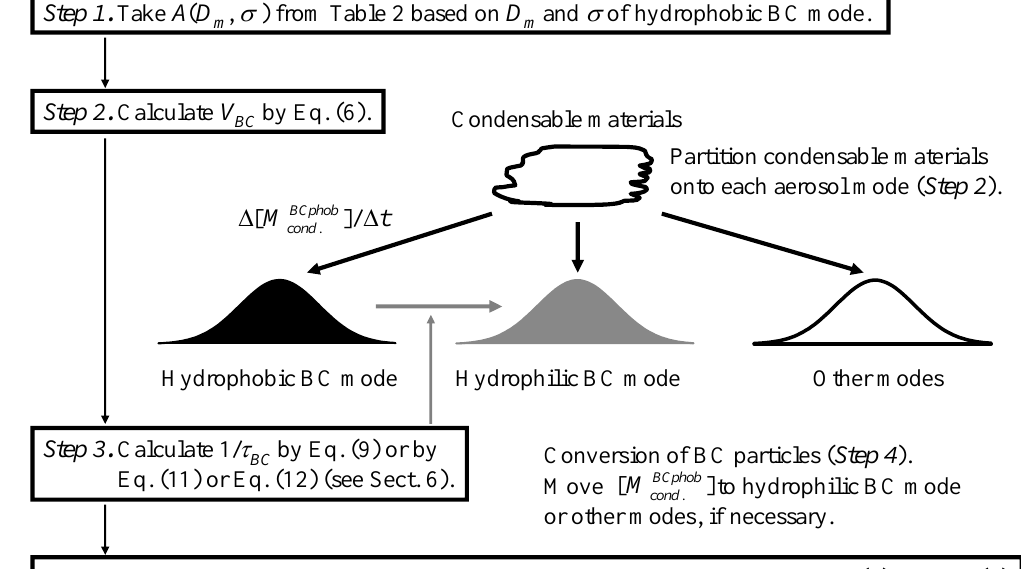
Fig. 3. Schematic diagram of an application method of the parameterization developed in this study to GCMs.